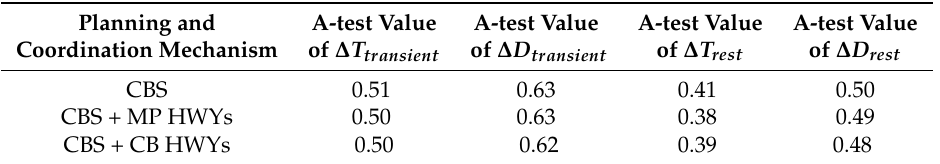
Table 6. MAS simulation A-test values of the average resilient responses for the considered runway reconfiguration events of all